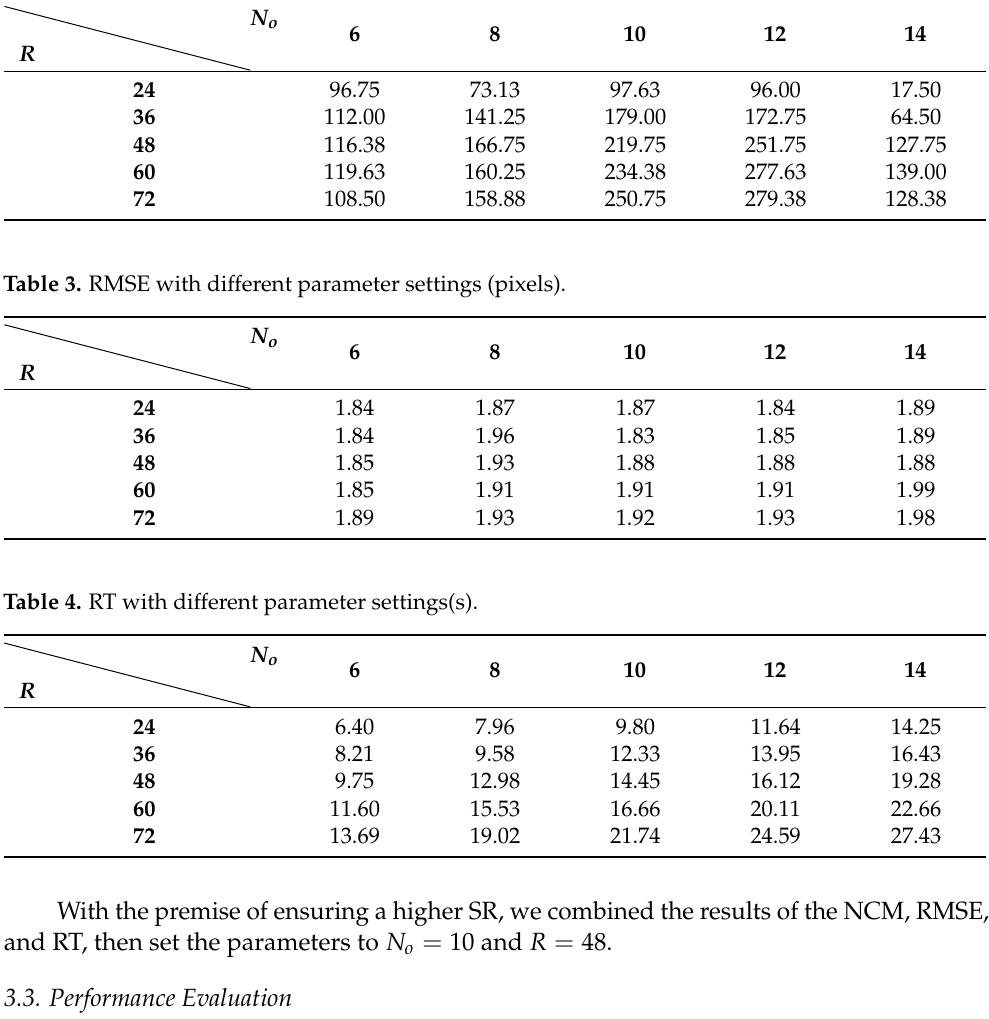
Table 2. NCM with different parameter settings.